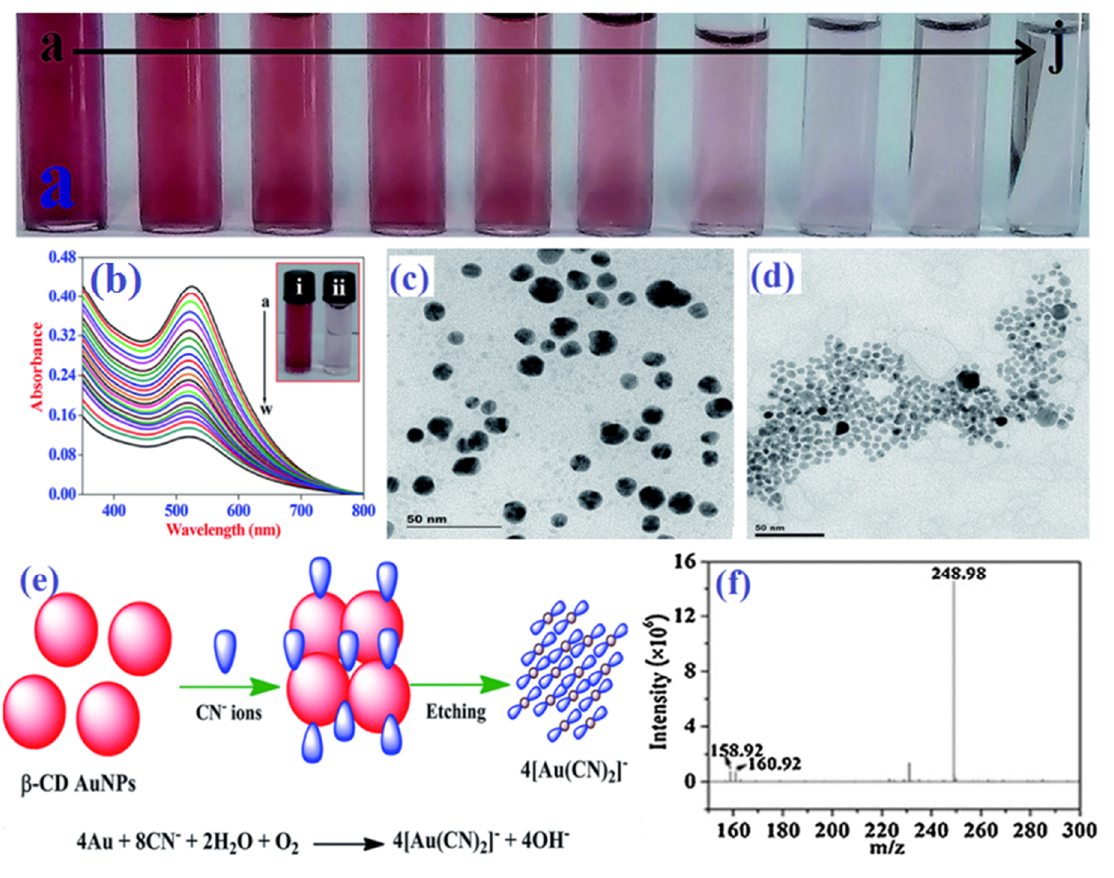
Figure 3. Colorimetric response ( a ) and SPR band changes ( b ) of AuNPs with increasing concentrations of cyanide (the a-to-w curves for 0 to 99 μM with a 4.5 μM step), HR–TEM images of AuNPs without ( c ) and with ( d ) cyanide anion, the probable mechanistic pathway of cyanide detection by AuNPs ( e ), and mass spectral data (f) for AuNPs with cyanide anion. ( a – e ) reproduced from Ref. [73] with permission from the Royal Society of Chemistry. ( f ) reproduced from Ref. [79] with permission from Elsevier.